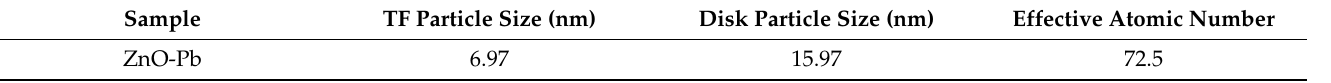
Figure 3. XRD graphs for ( A ) thin film ZnO-Pb and ( B ) 1 mm disk ZnO-Pb. Table 1. The particles size and (Zeff) for the samples used in the